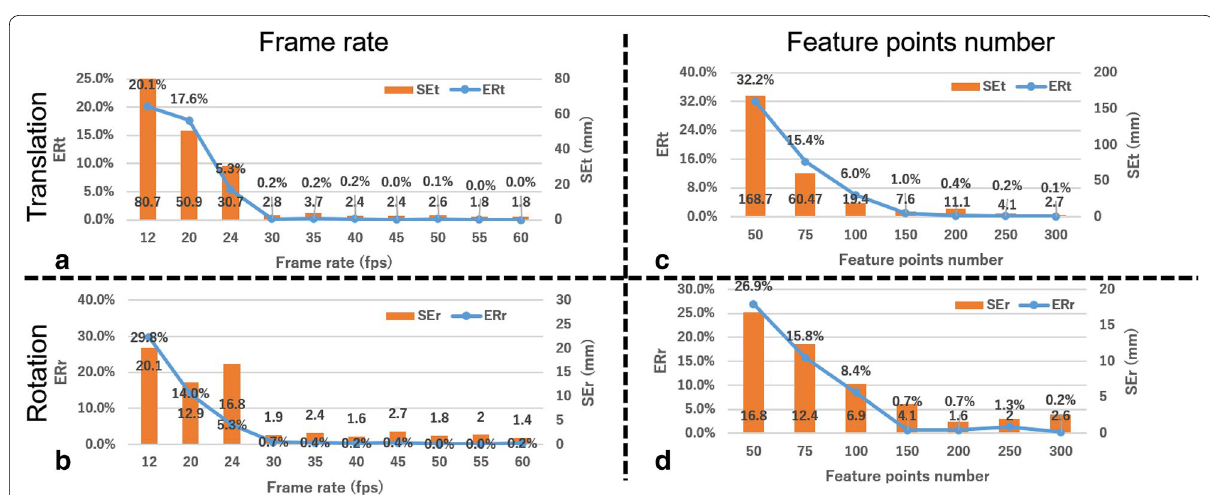
Fig. 14 Error rate and shift error with changing frame rate and feature point number. a , c Translation motion, b , d rotation motion. a and b show the effect of the frame rate, while c and d show the effect of the number of feature